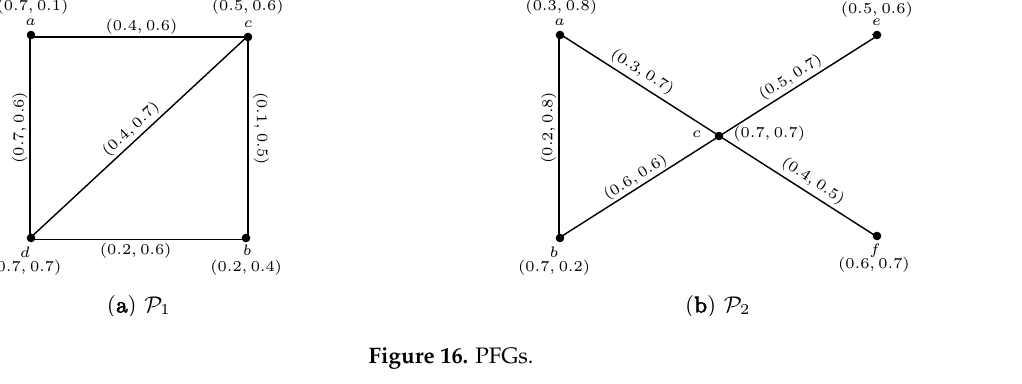
Figure 4.1: PFGs. Figure 16.